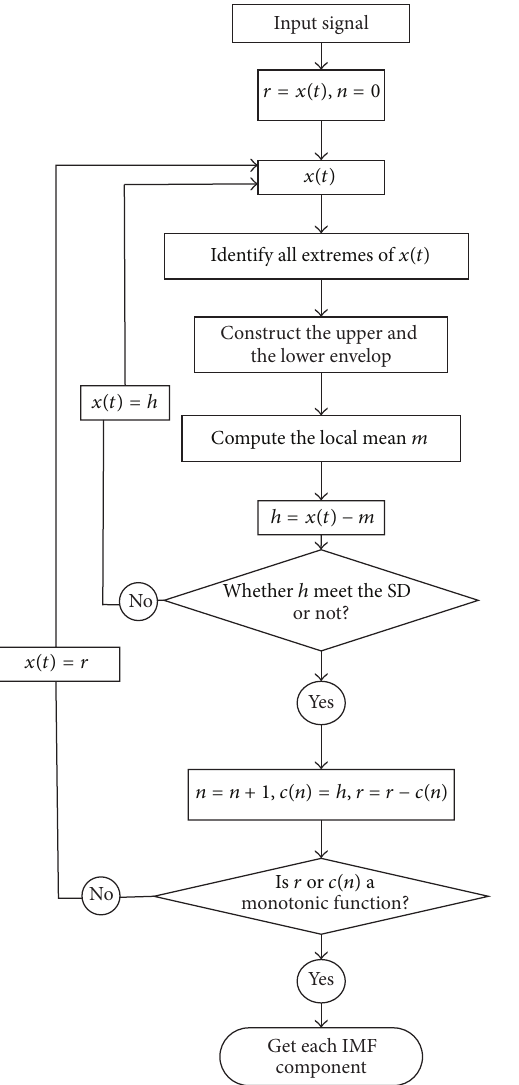
Figure 4: Calculation procedure diagram of EMD.